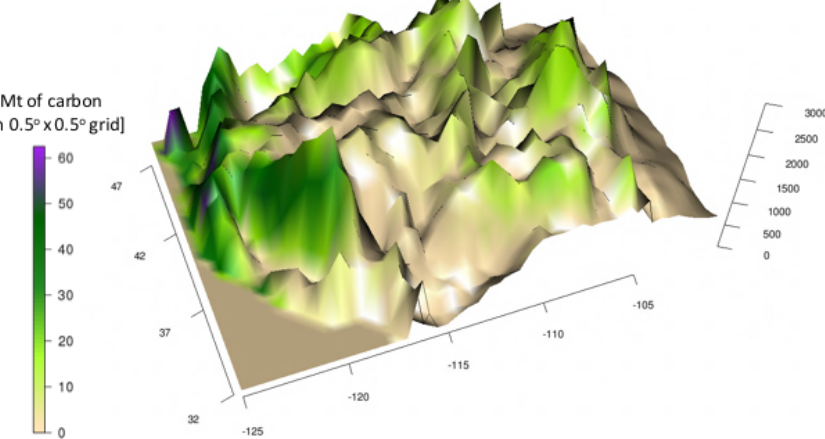
Figure 1. Above-ground biomass (megatons, Mt, of carbon) from the North American Carbon Program baseline dataset for year 2000 (Kellndorfer et al., 2013) overlaid on topographic surface in the western US, resolved at 0 . 5 ◦ × 0 . 5 ◦ grid